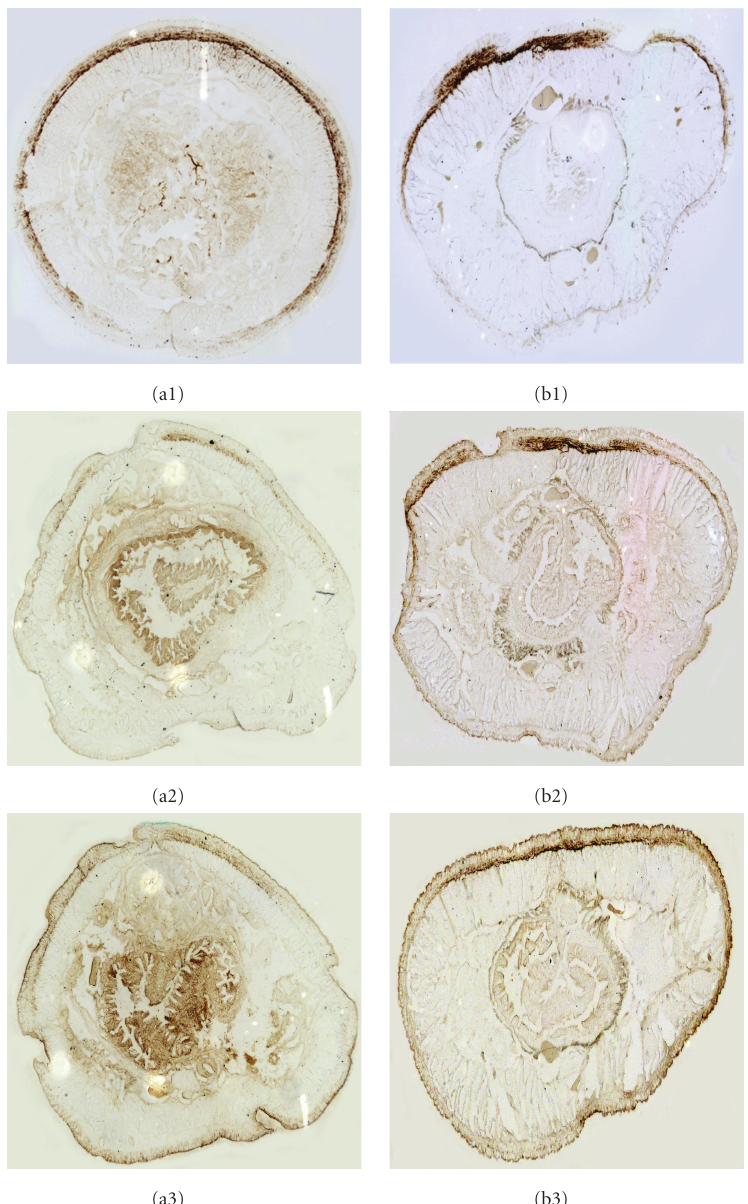
Figure 2: In situ localization of Ef P-II and Ef P-III-1 in the intestine of Eisenia fetida (a) segment 2 as shown in Figure 1. Anti- Ef P-II (panel a2) or anti- Ef P-III-1 (panel a3) as primary antibodies was added, without adding the primary antibodies as control (panel a1). (b) Segment 5 (see